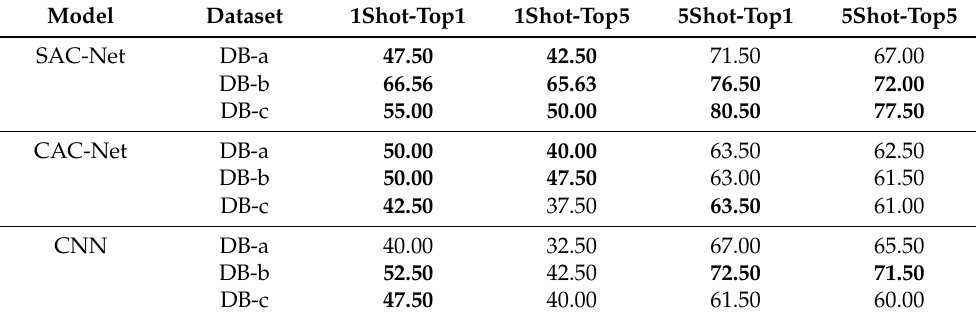
Table 10. 5-way 1-shot and 5-way 5-shot classification with different models on new subject on CapgMyo with MAML. The meta batch size is set to 8. The boldface numbers represent the best classification accuracies for each model and dataset compared with Table